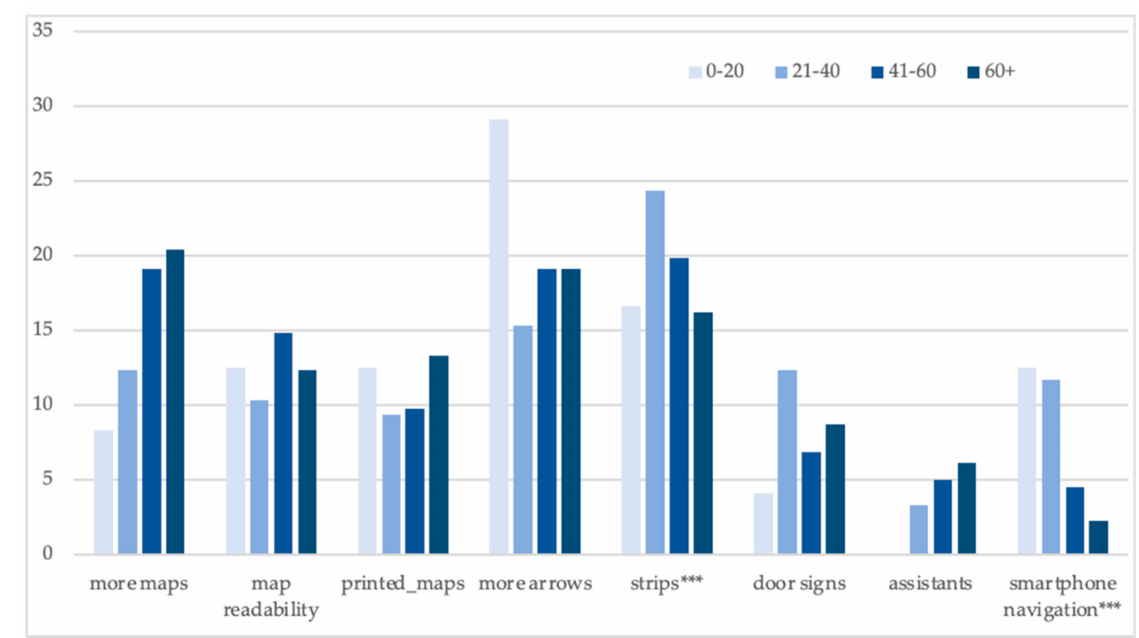
Figure 5. Age and navigational preferences: share of positive answers (%). Source: The Authors. Note: variables significantly related to the age are marked: * p < 0.05; ** p < 0.01; *** p <